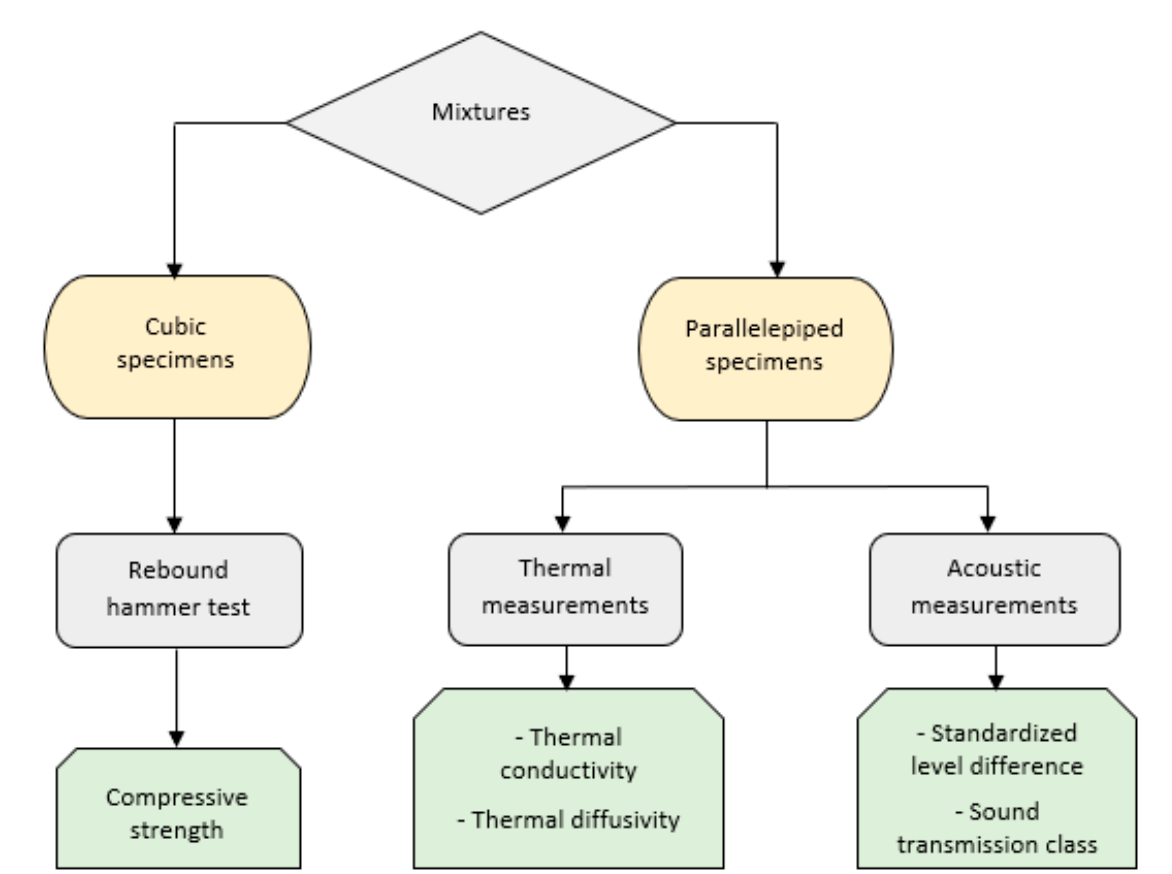
Figure 2. Flow chart for the different experimental tests carried out on the concrete specimens.